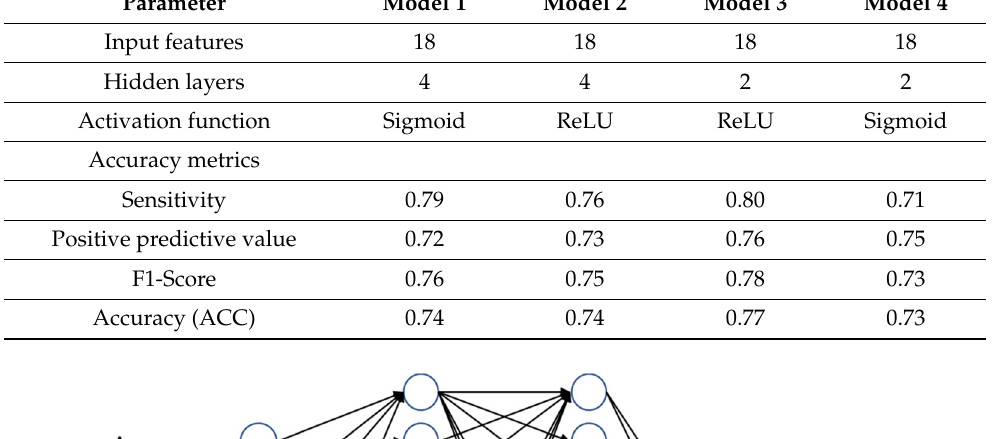
Table 3. Artificial neural network models’ architectures and accuracy metrics on the testing data.